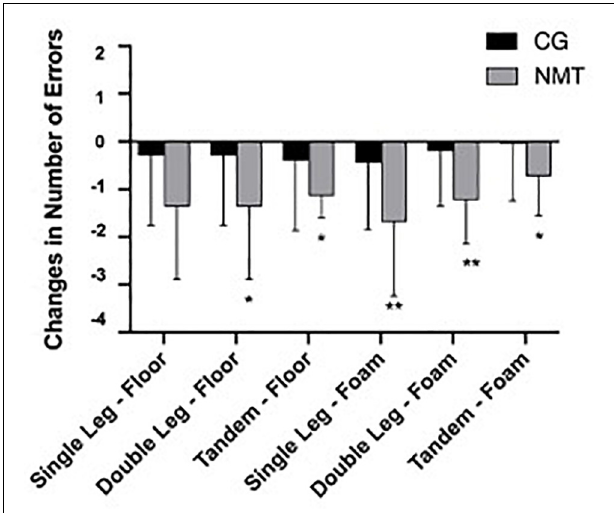
FIGURE 4 | Changes in number of errors of the Balance Error Scoring System test (NMT = neuromuscular training group; CG = control group; *inter group difference with p ≤ 0.05; **inter group difference with p ≤